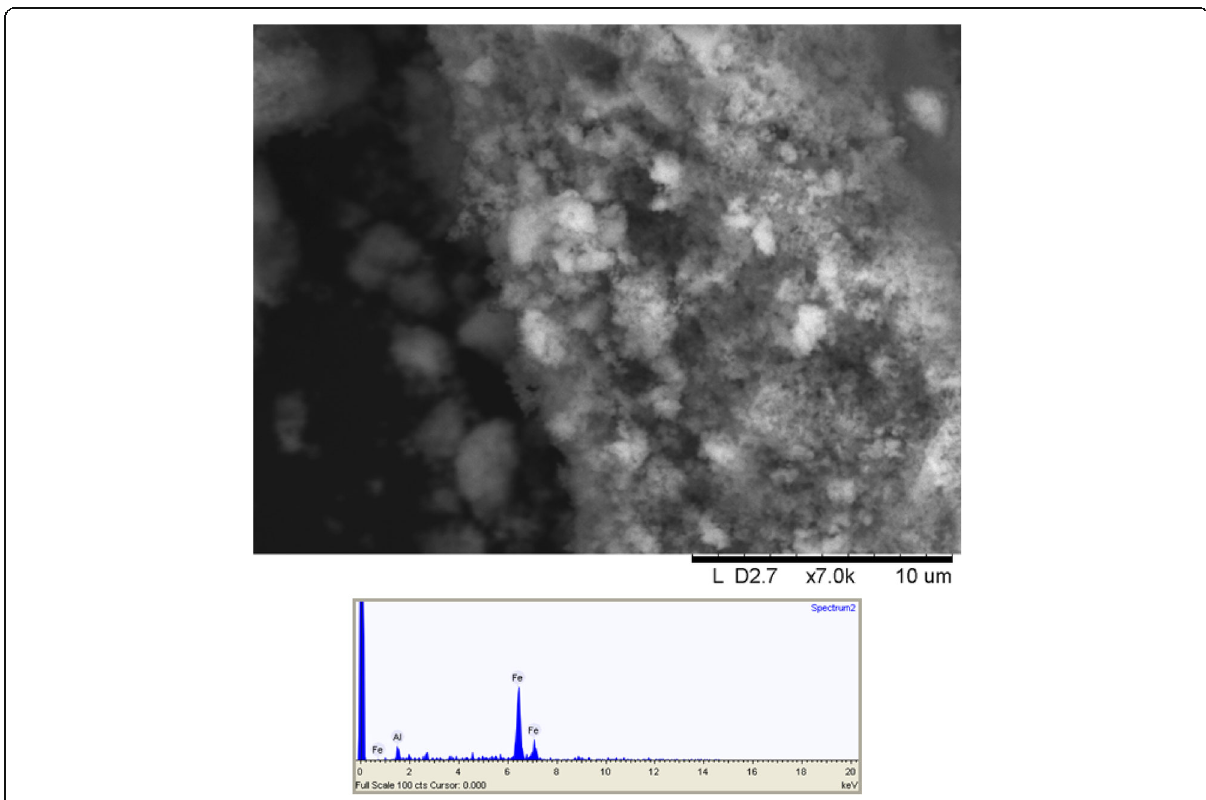
Fig. 10 Scanning electron image of γ -Fe 2 O 3 synthesized through yttrium directed sol-gel synthesis and an EDS spectrum of the same